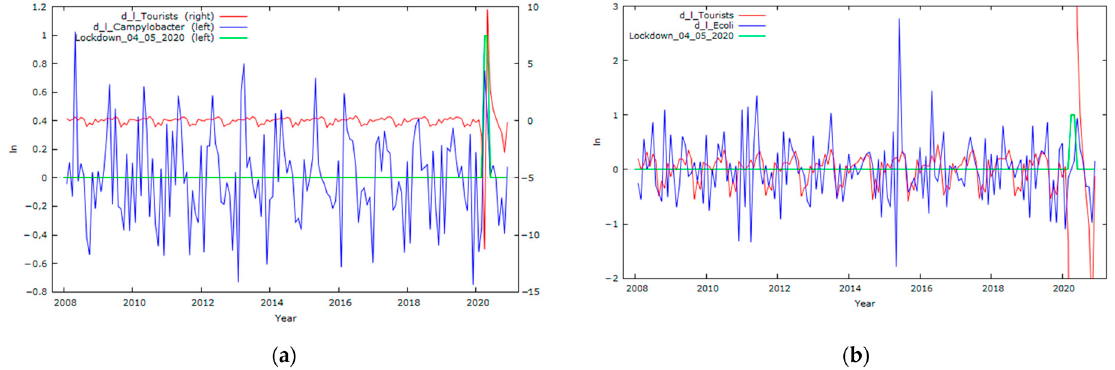
Figure A1. Dispersion of data for time series. ( a ) Between the ∆ ARR t − 1 and ∆ CA t − 1 ; ( b ) Between the ∆ ARR t − 1 and ∆ EC t − 1 .